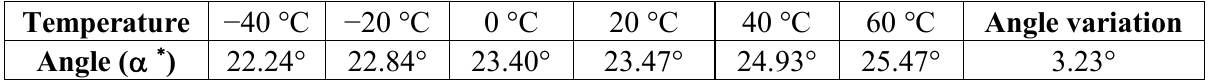
Table 2. The drift of the angular position of one antinode axis under temperature